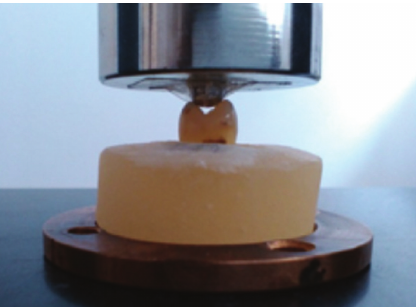
Figure 2: Mounted tooth in the acrylic cylinder under the LR5k testing machine.